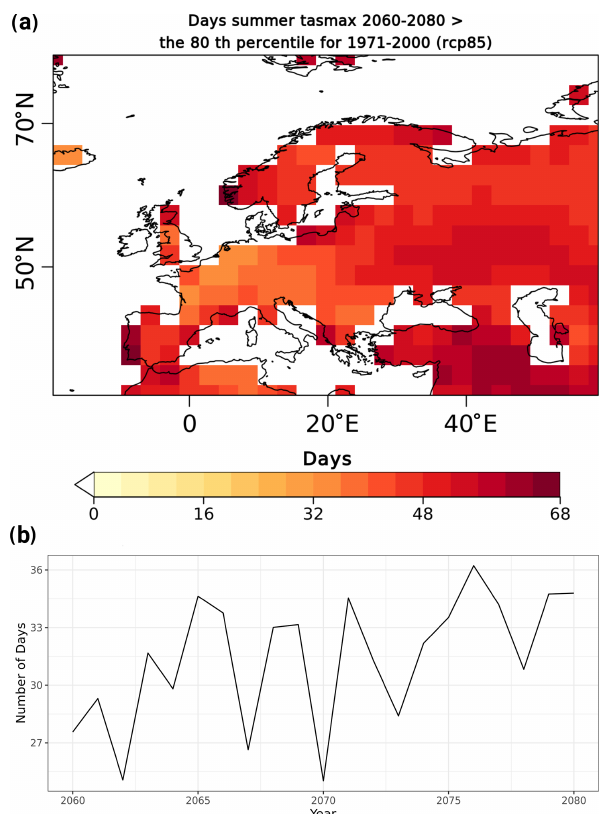
Figure 8. (a) Average annual number of summer days during the time period 2060–2080 when the daily maximum near-surface air temperature exceeds the 80th percentile of the 1971–2000 refer- ence period. The minimum duration of a heat wave event can be chosen in the recipe and is set to 5d here. (b) Mean annual number of summer days when the daily maximum near-surface air tempera- ture exceeds the 80th percentile of the 1971–2000 reference period averaged over the region shown in (a) . Results shown are for the RCP8.5 scenario simulated by BCC-CSM1-1 (see Sect. 3.3.1 for details on recipe_heatwaves_coldwaves.yml